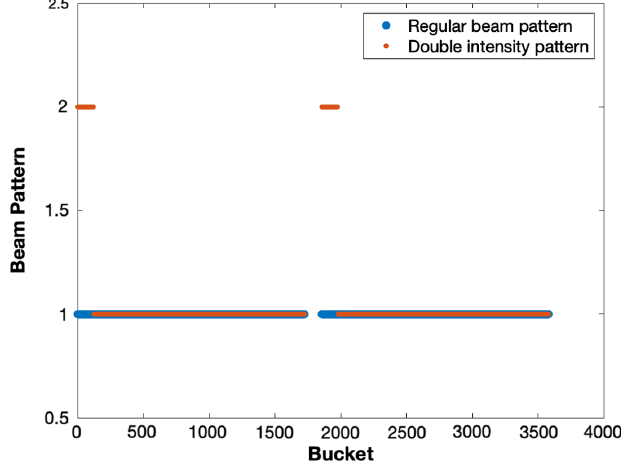
FIG. 12. Nominal and double intensity beam patterns (ion ring).